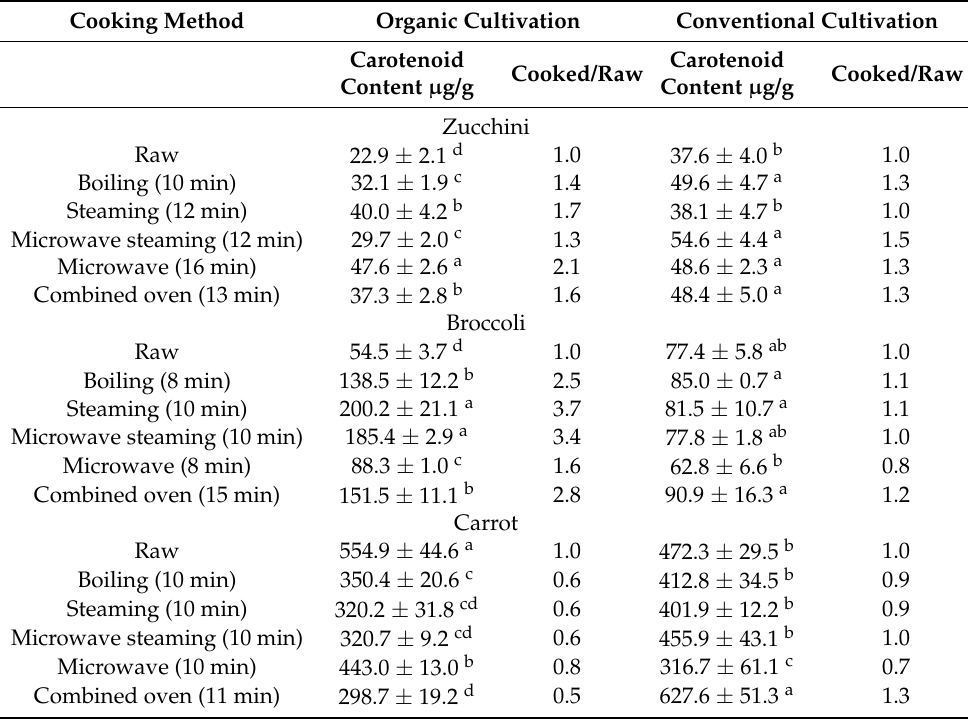
Table 1. Changes in the content of carotenoids in organic and conventional cultivation vegetables according to the cooking